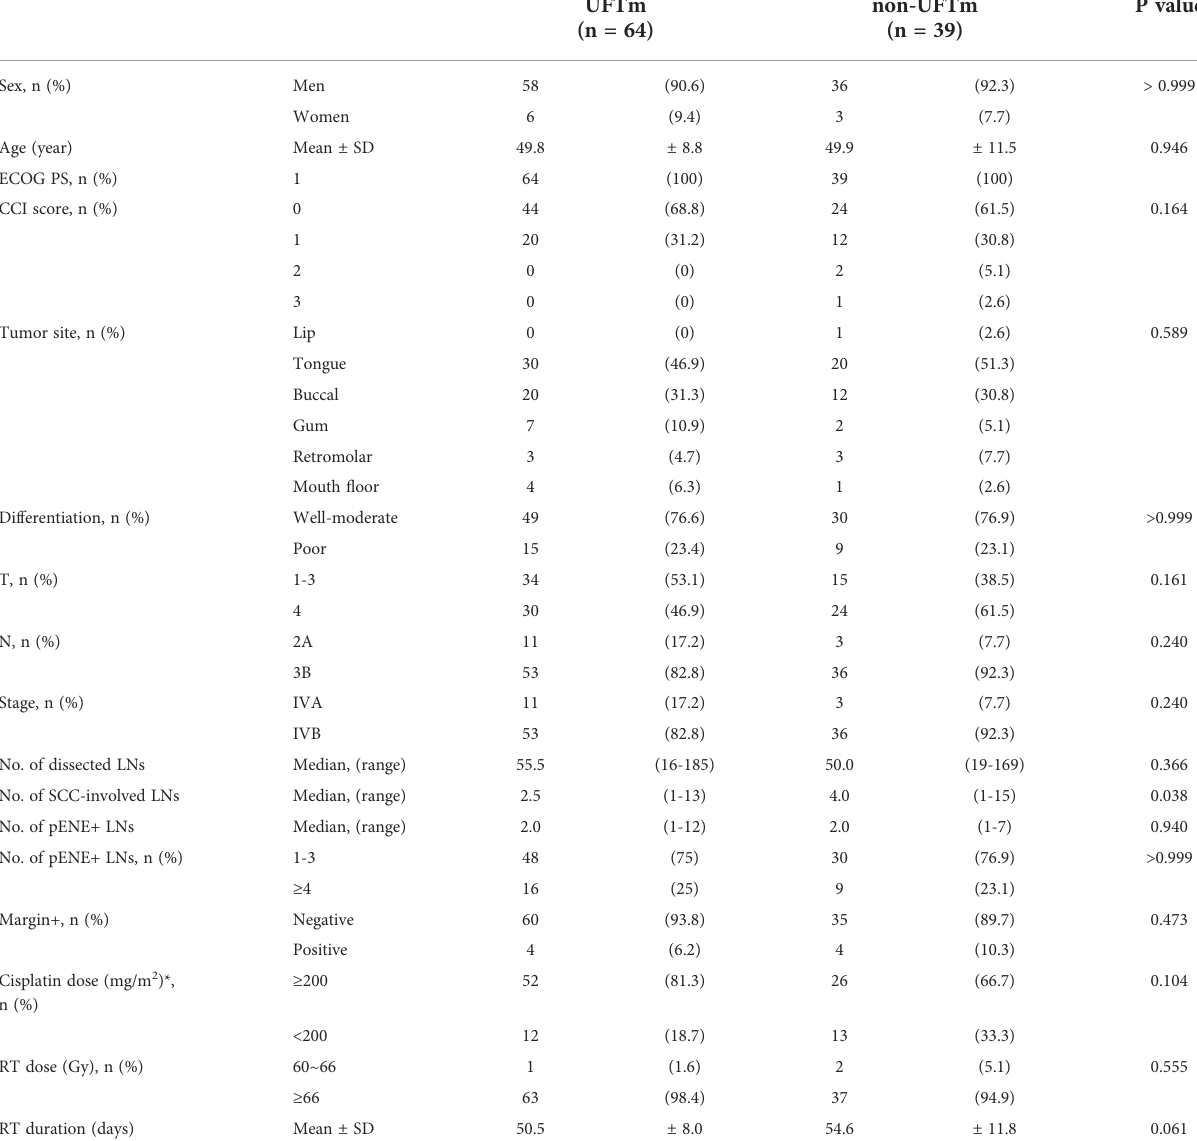
TABLE 1 Patient